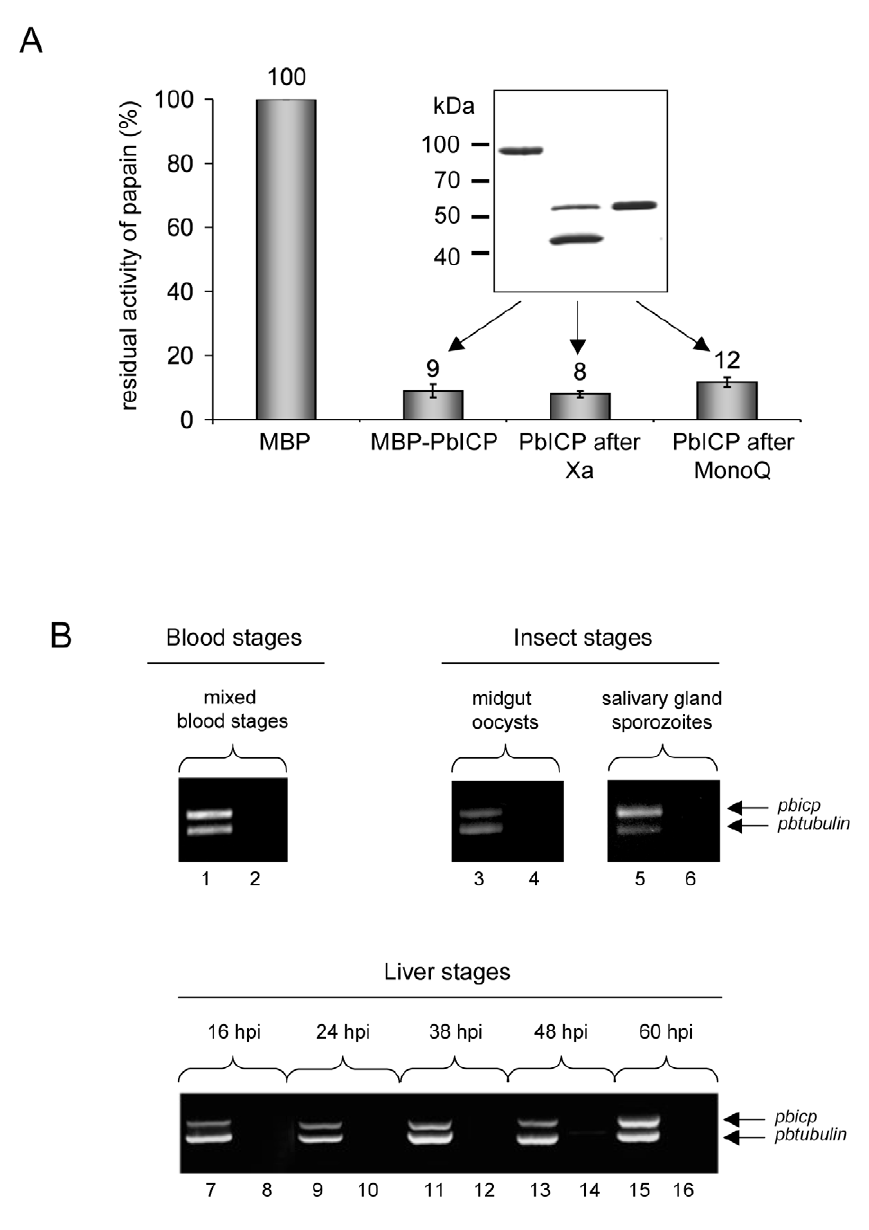
Figure 1. PbICP is a potent inhibitor of C1 cysteine proteases and the pbicp gene is constitutively transcribed. ( A ) Recombinant PbICP inhibits papain activity. Recombinant PbICP was produced in E. coli as an MBP-tagged soluble protein and purified from the bacterial lysate by amylose-bead affinity chromatography (insert, lane 1). The MBP tag was cleaved off by factor Xa digestion (insert, lane 2) and PbICP was purified using a MonoQ column (insert, lane 3). Proteins were resolved by SDS-PAGE and stained with Coomassie Blue. Hydrolysis of the substrate Z-Phe-Arg- pNA by papain was measured in the presence of 100 nM of the control protein MBP or 100 nM of MBP-PbICP, factor Xa-cleaved MBP-PbICP or PbICP after tag cleavage and MonoQ purification. Protease activity in presence of 100 nM MBP was considered 100% and the percentage of residual protease activity was calculated from that. MBP: maltose binding protein. ( B ) Constitutive transcription of the pbicp gene. RNA was isolated from P. berghei -infected mouse blood, mosquito midgut and salivary glands and from infected HepG2 cells. The purified RNA was then used for a duplex RT- PCR with specific primer pairs for the amplification of pbicp cDNA and the tubulin cDNA of P. berghei . In samples with odd numbers, cDNA was used as a template. In samples with even numbers, reverse transcriptase was omitted from the cDNA preparation reaction to control for the presence of genomic DNA.